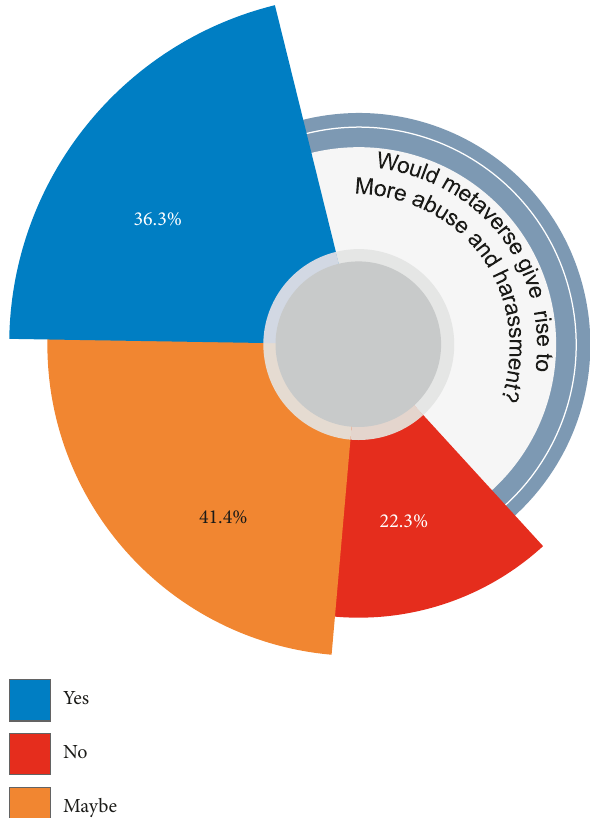
Figure 13: Summarization of the responses when people were asked if a metaverse would aggravate the problem of online abuse and